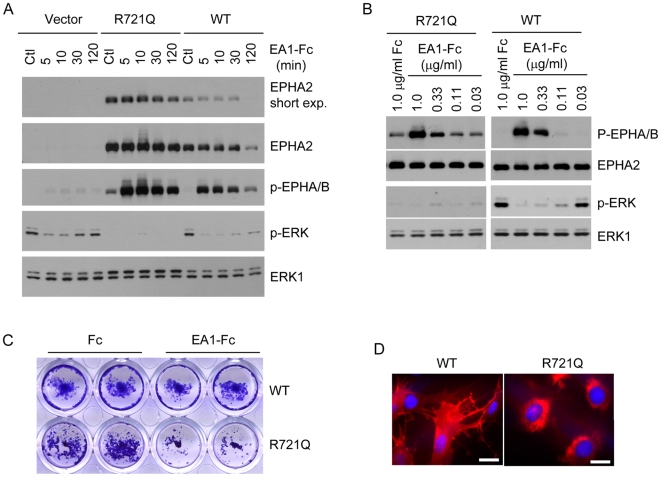
Functional characterization of Arg721Gln variant associated with human cataract.(A,B) Arg721Gln mutation causes an increased basal activation of EPHA2 kinase, which was correlated with dramatically reduced basal ERK1/2 activities. In a kinetic study (A), HEK 293 cells expressing WT-, Arg721Gln-EPHA2 or vector control were stimulated with 2 µg/ml ephrin-A1-Fc for the indicated times. In a separate experiment, a dose-response study was carried out (B), where different doses of ephrin-A1-Fc were used to stimulate cells expressing WT- or Arg721Gln-EPHA2 for 10 min. Cell lysates from both experiments were blotted with the indicated antibodies as described previously [53]. (C) HEK 293 cells expressing Arg721-Gln mutant EPHA2 but not WT-EPHA2 were growth-inhibited by ephrin-A1 in a clonal growth assay as described previously [26]. About 200 cells/well were seeded in a 24-well culture dish and cultured for 10 days in the presence or absence of ephrin-A1. (D) Stochastic intracellular trapping of Arg721Gln mutant in MEF cells derived from Epha2 knockout embryos. Shown is a cluster of cells with the mutant EPHA2 trapped inside the cells. In contract, WT-EPHA2 was primarily expressed on the cytoplasmic membrane. Scale bar: 5 µm.